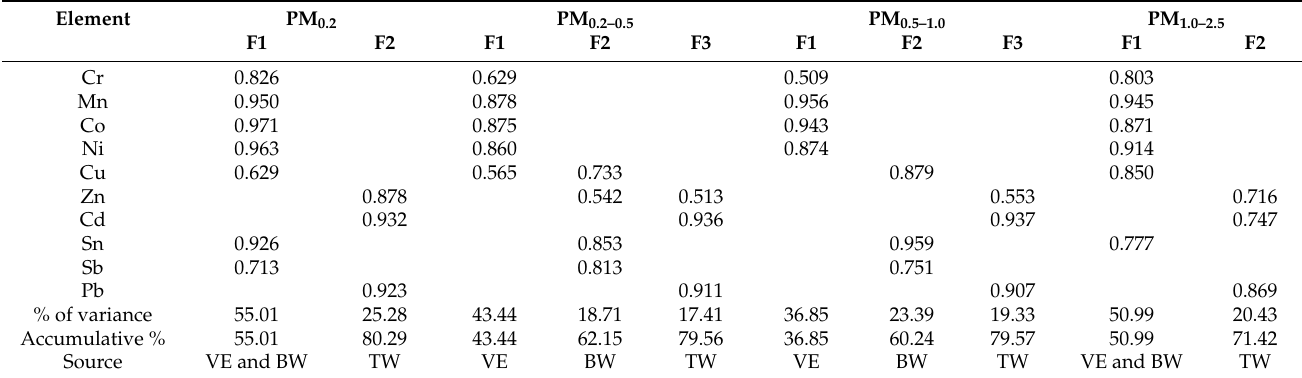
Table 4. Maximum variance rotation factor analysis of